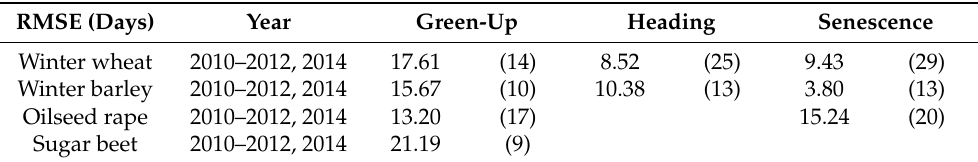
Table 3. RMSE in days between the green-up, heading, and senescence dates calculated using homogeneous MODIS pixels and field data (DWD and UFZ) for different crops. The corresponding number of field observations for calibration is given in